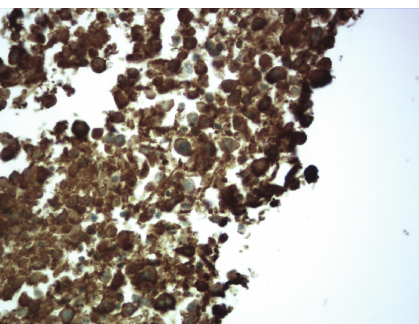
Figure 4: Postmortem bone marrow biopsy showing strongly positive Immunohistochemical stain for lambda immunoglobulin lightchainwithintheplasmacellcytoplasm.(TheIHCissuboptimal secondary to protein degradation during tissue autolysis in devital- ized